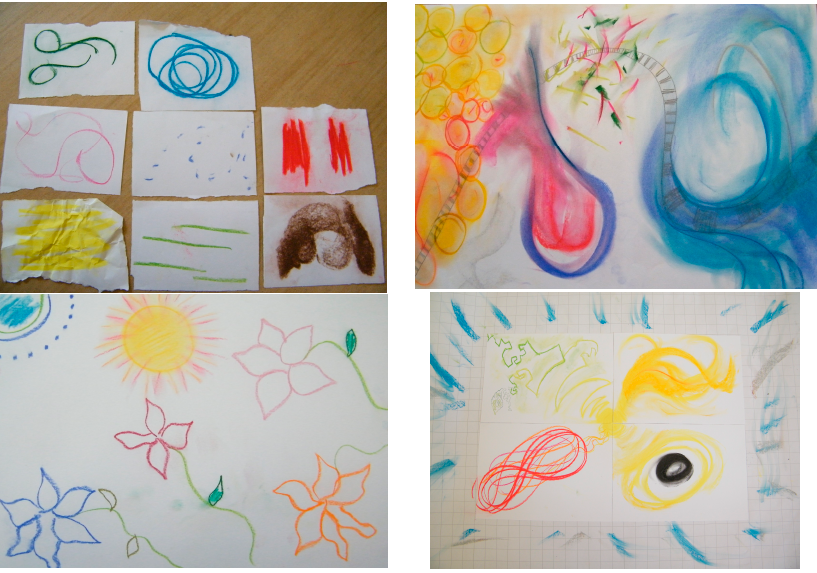
Figure 4. Photos of the second four creations with paper, color, and/or words that emerged from the artistic inquiry in this study.